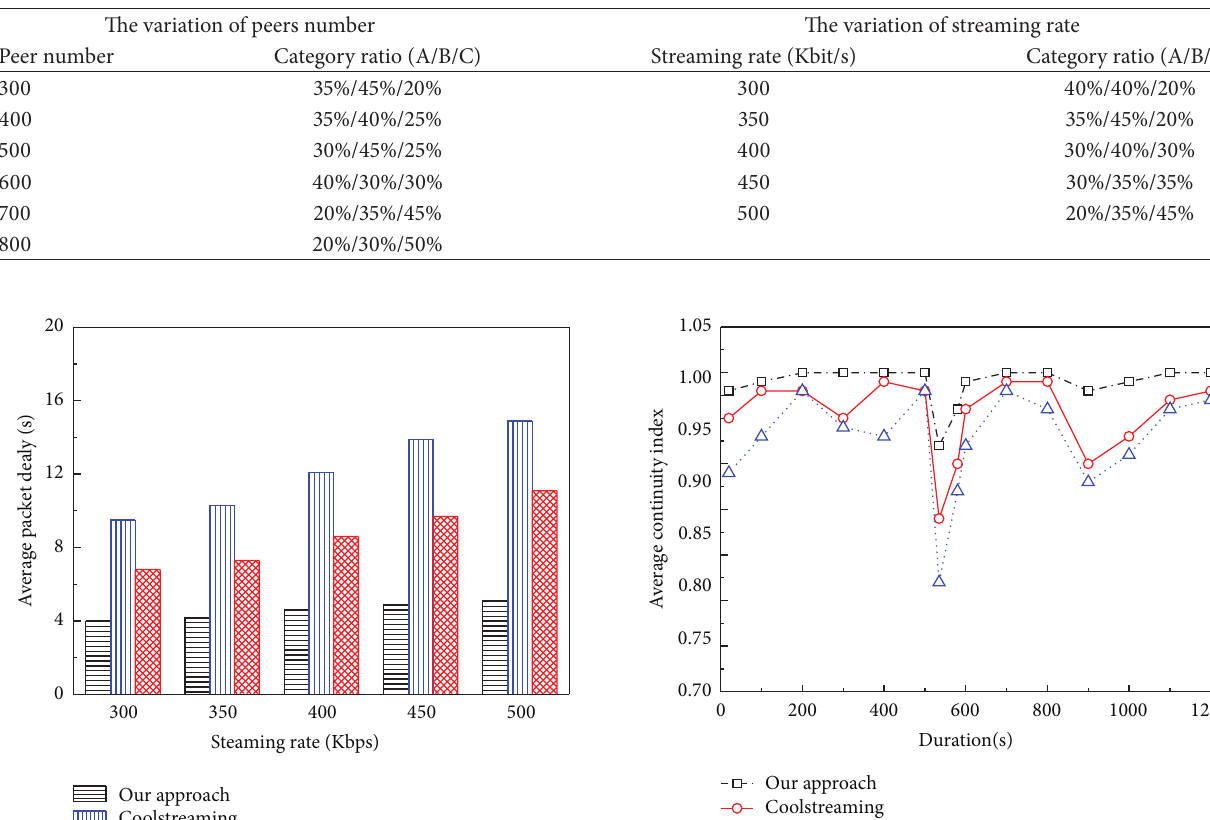
Table 4: Peer bandwidth distribution versus peers number and streaming rate.